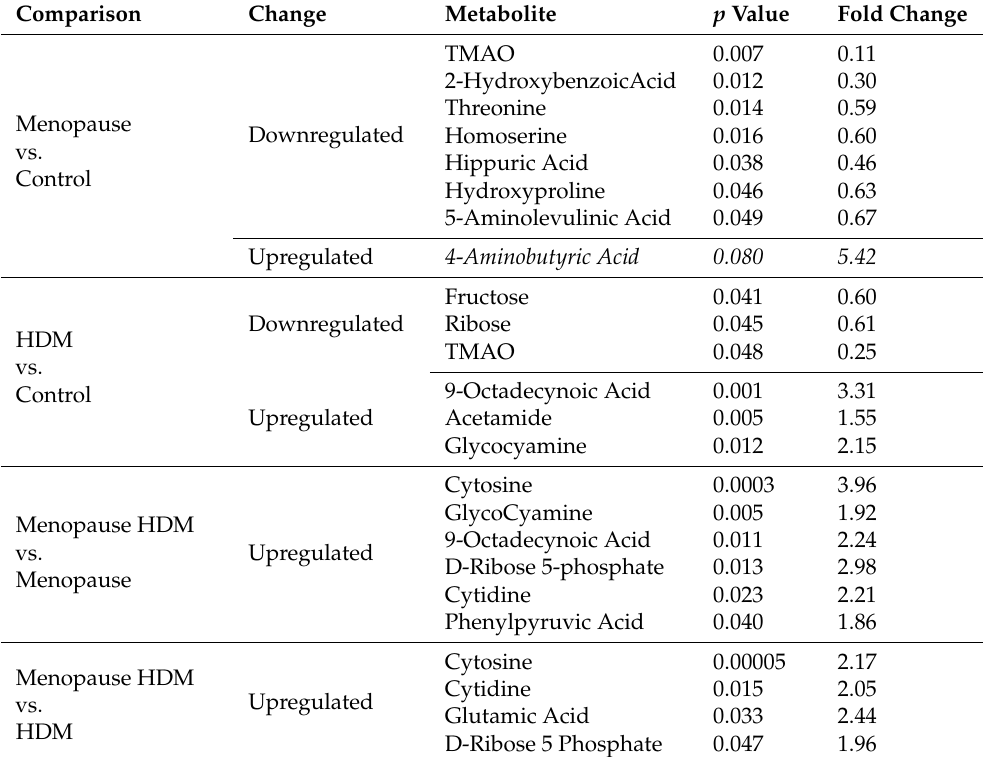
Table 1. Significantly different individual metabolites in the